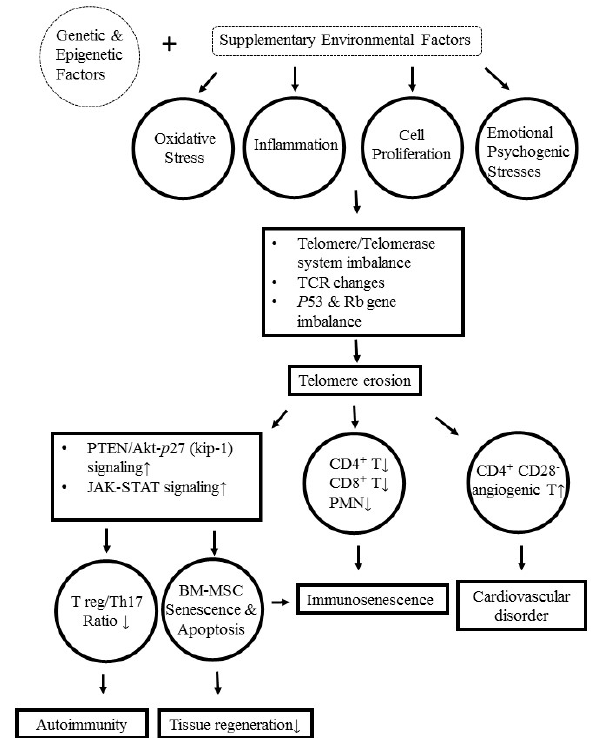
Figure 6. The molecular and cellular mechanisms underlying telomere / telomerase disequilibrium in inducing immunosenescence, increased CD4 + CD28 − angiogenic T cell production, autoimmunity, and impaired tissue regeneration in patients with SLE. Broken lines are not discussed in the present review. BM-MSC: Bone marrow-derived mesenchymal stem cells; TCR: T cell receptor; PMN: Polymorphonuclear neutrophil: JAK-STAT: Janus kinase and signal transducer and activator of transcription; MW: Molecular weight; Treg: Regulatory T cell; PTEN: Phosphatase and tensin homolog; Akt: RAC-alpha serine / threonine-protein kinase; kip-1: Cyclin-dependent kinase inhibitor